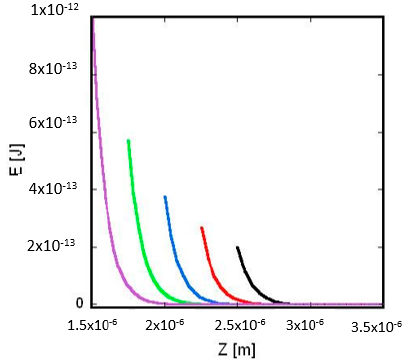
Figure 3. Interaction energy of two charged spheres surrounded by electrolyte (dependence from radius): the interaction energy between the two spheres, E , is plotted against the distance between the centers of the two spheres, Z . The total charge of the left and right sphere is Q 1 = − 8.3566 × 10 − 13 C and Q 2 = − 3.34265 × 10 − 12 C , respectively. The radius of the right sphere (see Figure 1) is R 2 = 10 − 6 m, the electrolyte’s ion concentration is C = 0.01 mol/m 3 , the temperature is T = 300 K and the respective Debye length (calculated by Equation (A2)) is λ D = 9.62 × 10 − 8 m. Purple curve: R 1 = 5 × 10 − 7 m; green curve: R 1 = 7.5 × 10 − 7 m; blue curve: R 1 = 1 × 10 − 6 m; red curve: R 1 = 1.25 × 10 − 6 m; black curve: R 1 = 1.5 × 10 − 6